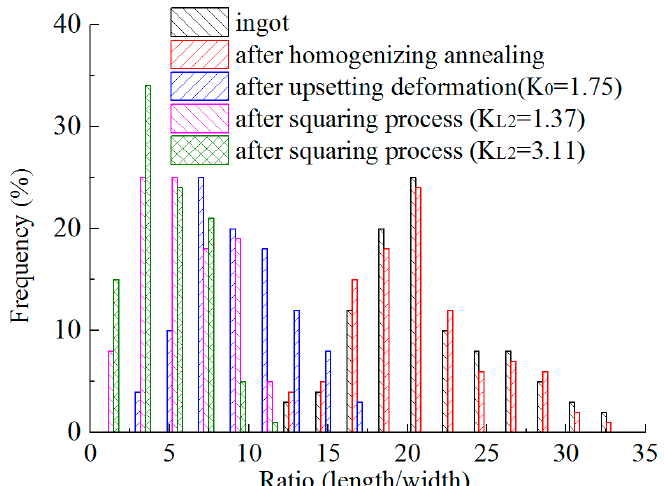
Figure 7. Distribution of the ratios (length/width) of the Y phases after the heat treatment and forging processes.